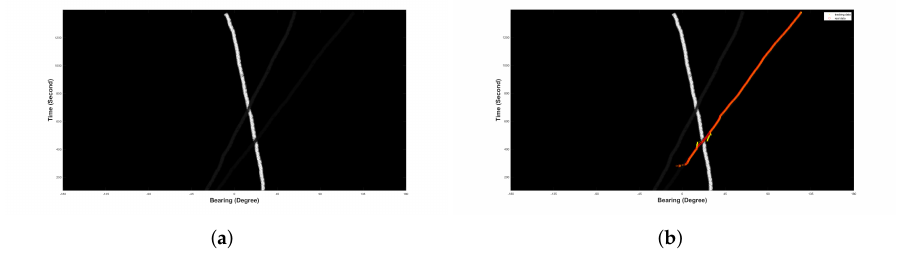
Figure 9. Tracking results at SIR = − 23 dB. ( a ) Jamming target at SIR = − 23 dB. ( b ) Tracking result with proposed